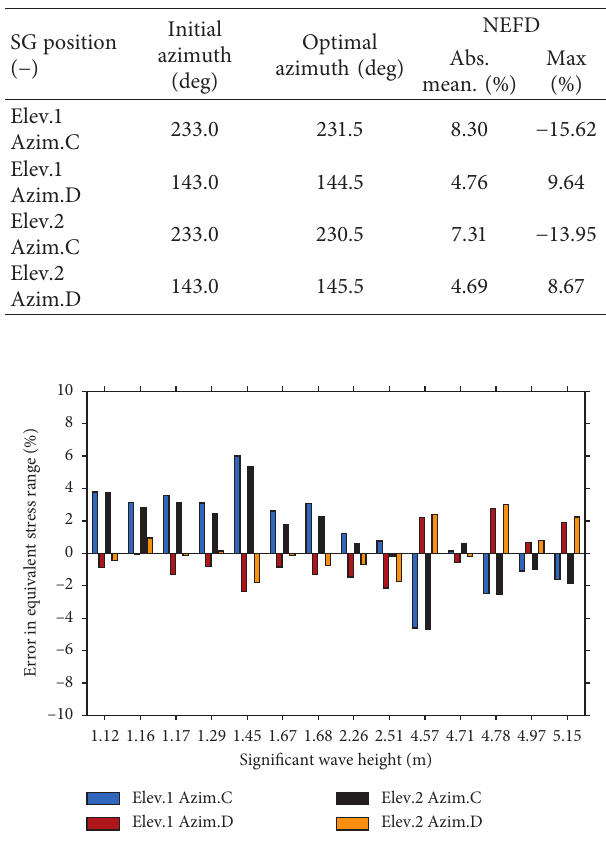
Figure 12: Error in equivalent stress range based on optimal azimuth values.